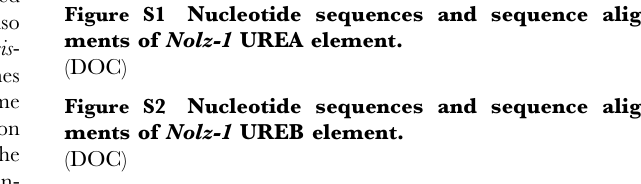
Figure S1 Nucleotide sequences and sequence align- ments of Nolz-1 UREA element. Figure S2 Nucleotide sequences and sequence align- ments of Nolz-1 UREB element. (DOC) Figure S3 Whole mount X-gal staining of E11.5 UREA- LacZ embryos. A: In embryos of line # 21, X-gal-positive signals are selectively detected in two discontinuous domains of hindbrain (arrowheads) and in the spinal cord (sc). B–C: In embryos of line # 26, X-gal-positive signals are detected in a selective domain of hindbrain (arrowhead), in spinal cord (sc) and in the lateral plate mesoderm (arrows). D–G: In addition to the spinal cord (sc) and caudal hindbrain (hb), X-gal-positive signals are also detected in the otic vesicle (ot, E, G) and a specific domain at oral region (arrows, F) in line # 22 embryos. A, B, D: lateral view; C, E: back view; F: front view; G: transverse view of truncated hindbrain (hb) of UREA-LacZ embryo. (TIF) Figure S4 Detection of X-gal-positive signals in spinal cord of E13.5 UREA-LacZ embryos. A–K, transverse sections of E13.5 spinal cord. Panels are arranged from the rostral (A, E, I) to caudal levels (D, H, K). A, B at the cervical level; B–C, F–G and I–J at the thoracic level; D, H, K at the lumbar level. X-gal- positive signals are detected in ventral spinal cord of # 22 (lightly stained, A–D) and # 26 (lightly stained, E–H; darkly stained, I–K) at all levels along the rostral-to-caudal axis in embryonic spinal cord. X-gal-positive signals in line # 26 are mainly detected in a domain near the floor plate (E–K), whereas in line # 22, X-gal- positive signals are found in broader regions, including the lateral domains of ventral spinal cord (A–D). Note that at caudal levels, X-gal-positive signals are also observed in scattered cells in dorsal spinal cord with moderate expression levels (D). Figure S5 Double labeling of LacZ mRNA and Nolz-1 protein or Isl1/2 protein in E14.5 spinal cord of UREA- LacZ embryos. A–C, D–F: Double labeling of LacZ mRNA (purple) and Nolz-1 protein (brown) in spinal cord of line # 22 UREA-LacZ embryos. D, E, F are high magnification views of A, B, C, respectively, in the ventrolateral spinal cord. The # symbols indicate the regions where many LacZ and Nolz-1 co-expressing spinal neurons are observed (D–F). J–L: Double labeling of LacZ mRNA (purple) and Isl1/2 (brown) proteins. A few cells expressing LacZ mRNA at low level co-express Isl1/2 (single arrow in inset of H). J–K: Double labeling of LacZ mRNA (purple) and Nolz-1 protein (brown) in spinal cord of line # 26 UREA-LacZ embryos. Many LacZ-positive cells co-expressing Nolz-1 (arrows in inset of K) are observed. D, J are transverse sections of spinal cord at the level of heart; B, E, H at the level of upper abdominal; C, F, I, J–L at the level of lower abdominal. Figure S6 Whole mount X-gal staining of E15.5 brain of line # 26 UREA-LacZ embryo. Two X-gal-positive longitudi- nal columns (arrows, B), similar to that observed in line # 22 (Fig. 4D) are detected in line # 26 hindbrain (hb). A: dorsal view; B: ventral view; C: side view.